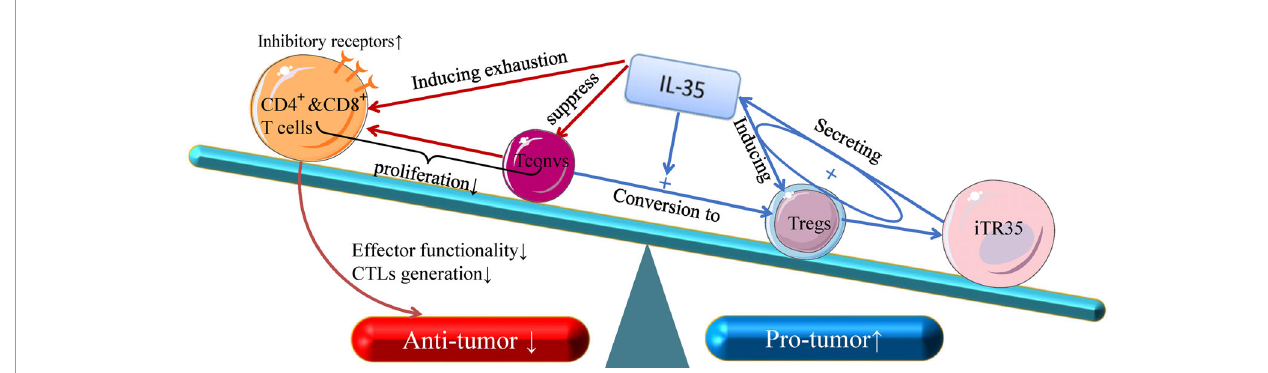
FIGURE 1 | The anti- and pro-tumor effects of T-cell subsets in response to IL-35. Recent insight into the biology of IL-35 suggests that it can both suppress naive T cells (Tconv cells) and convert these naive Tconv cells into strongly suppressive induced Treg cells (iTr35 cells). Through a positive feedback loop associated with the expression of IL-35, Treg cells can inhibit the differentiation of CD4 + T cells into Th17 and Th1 cells. In addition, IL-35 is dispensable for the control of CD8 + T cells, and IL-3- dependent transcription signal depletion as well as the inhibitory receptor activation of CD8 + T cells play key roles in reducing CTL effector functions, which are critical for cellular anti-tumor responses. Given its broad immunoregulatory properties and its pro-tumor functions, IL-35 represents an important functional cytokine for Tregs that is secreted by multiple immunosuppressive cell